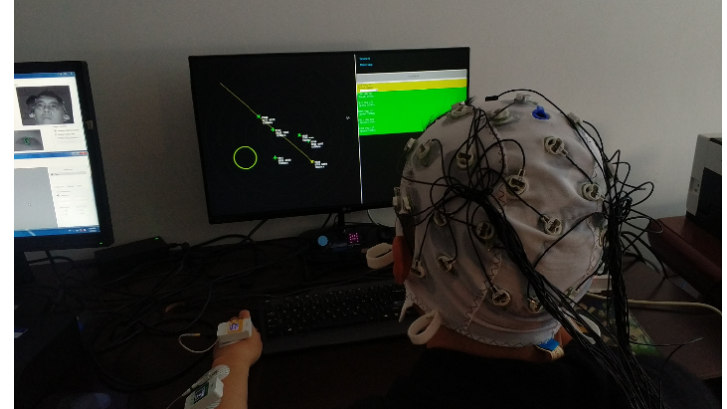
Figure 4. Data collecting during an experiment.